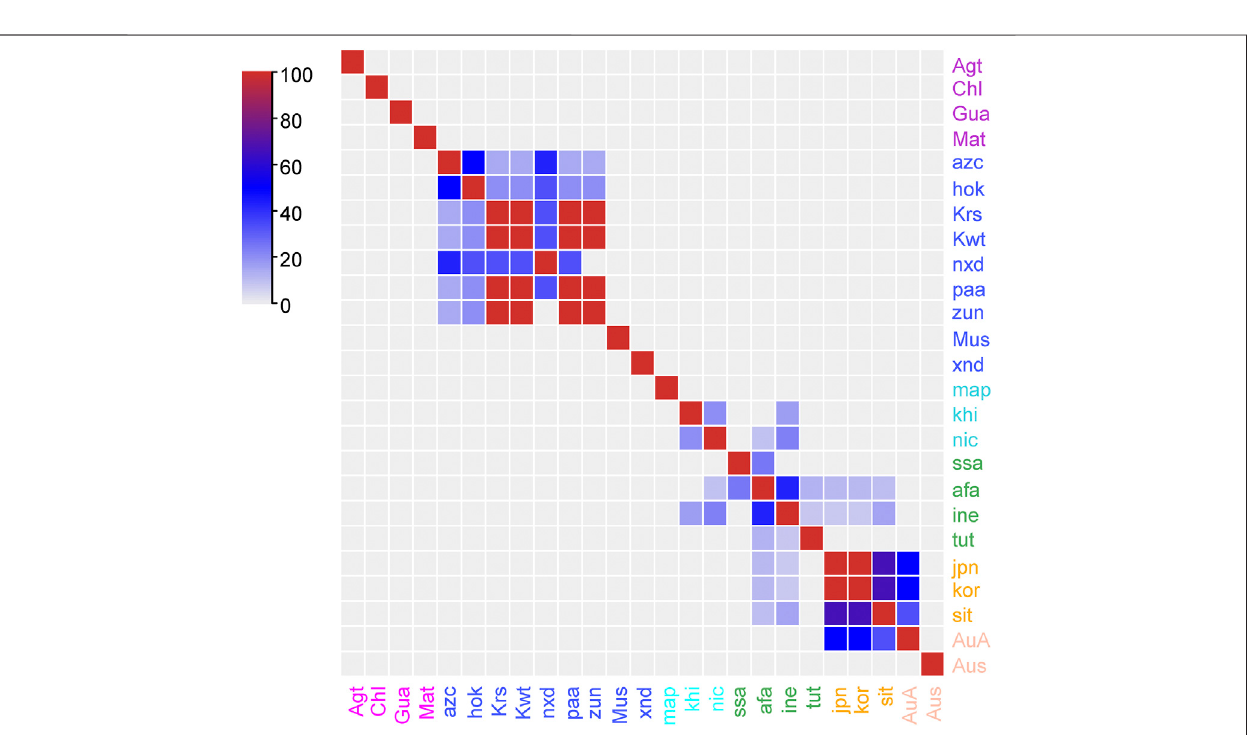
FIGURE 4 | Pairwise comparison of the Jaccard Index (JI) between ethnobotanical knowledge on Lycium spp. of different cultures as represented by language families.